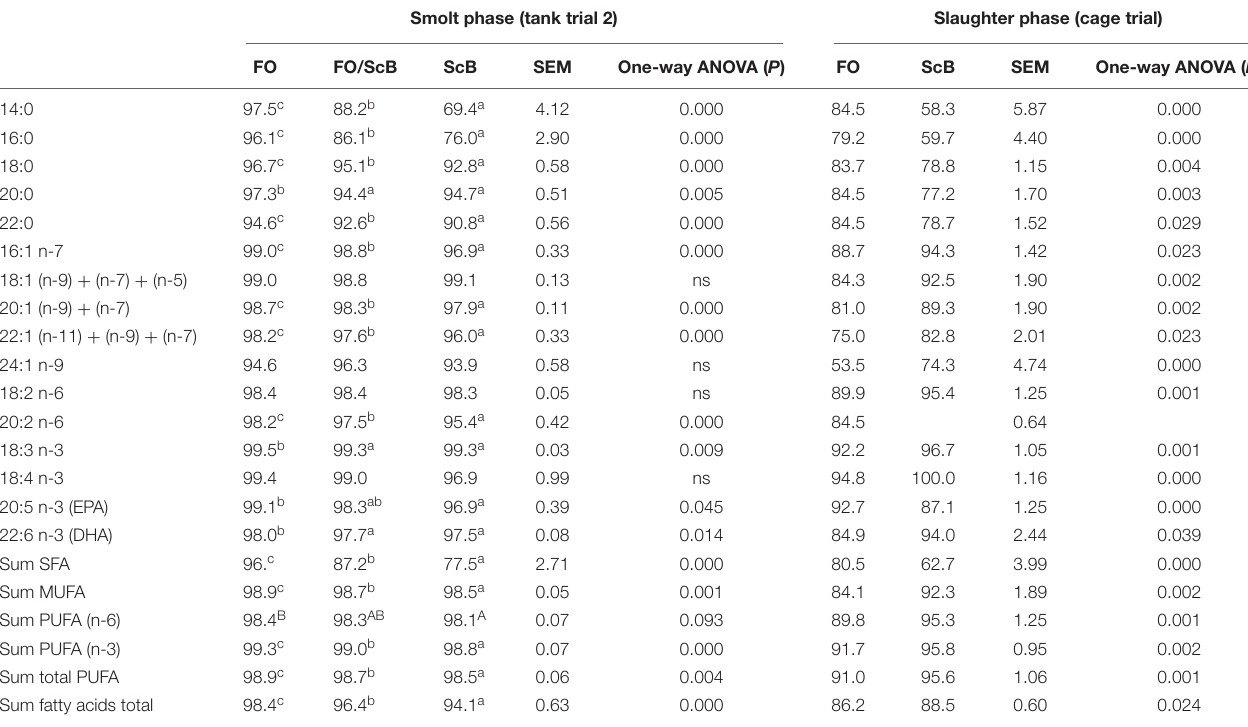
TABLE 4 | Dietary fatty acid apparent digestibility coefficient (ADC) (%) in Atlantic salmon fed diets with fish oil (FO) or ScB as supplementary marine omega 3 fatty acid sources at slaughter (fish mean body weight 2.8–3.2